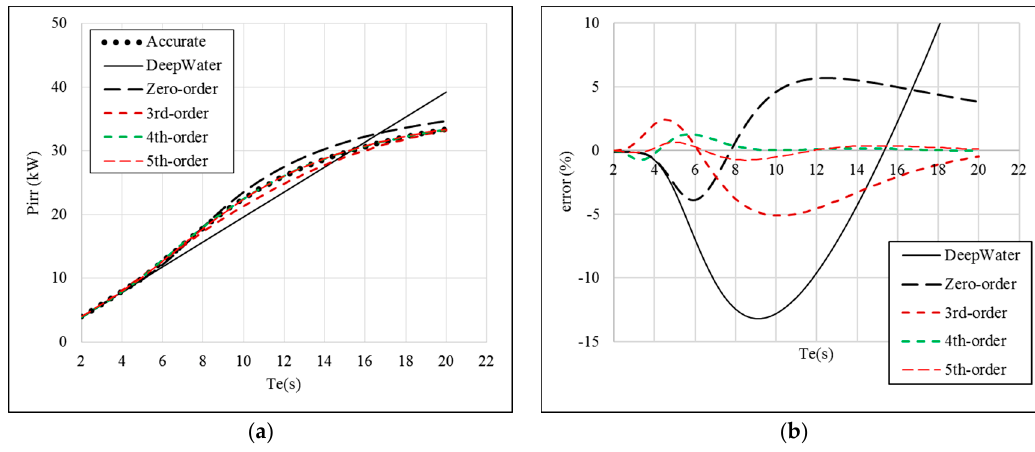
Figure 6. Comparison of the calculated wave power and the corresponding error using different methods for Bretschneider spectra of H m 0 = 2 m (water depth = 25 m). ( a ) Calculated wave power; ( b ) Error.